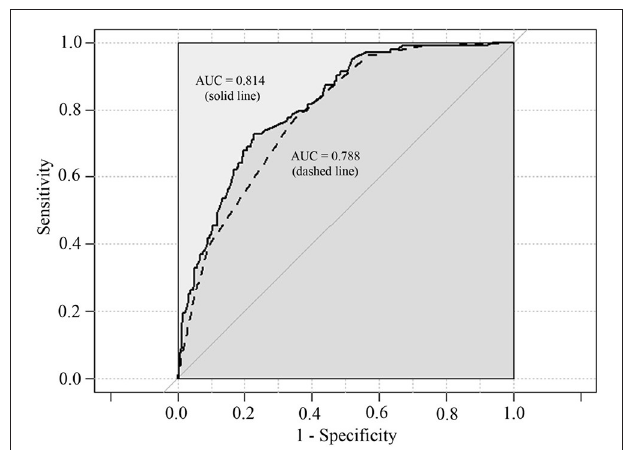
FIGURE 1 | Predictive ability of multivariate logistic regression models for IP. Area under the curves (AUC) for solid line is 0.814 (95% CI 0.771–0.857, P < 0.001). AUC for dashed line is 0.788 (95% CI 0.743–0.832, P < 0.001).